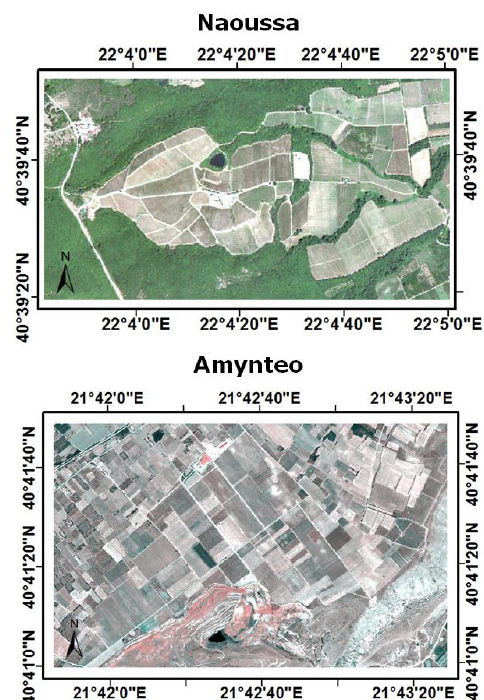
Figure 1. The two study areas in Northern Greece, natural color RGB, obtained from the WorldView-2 data